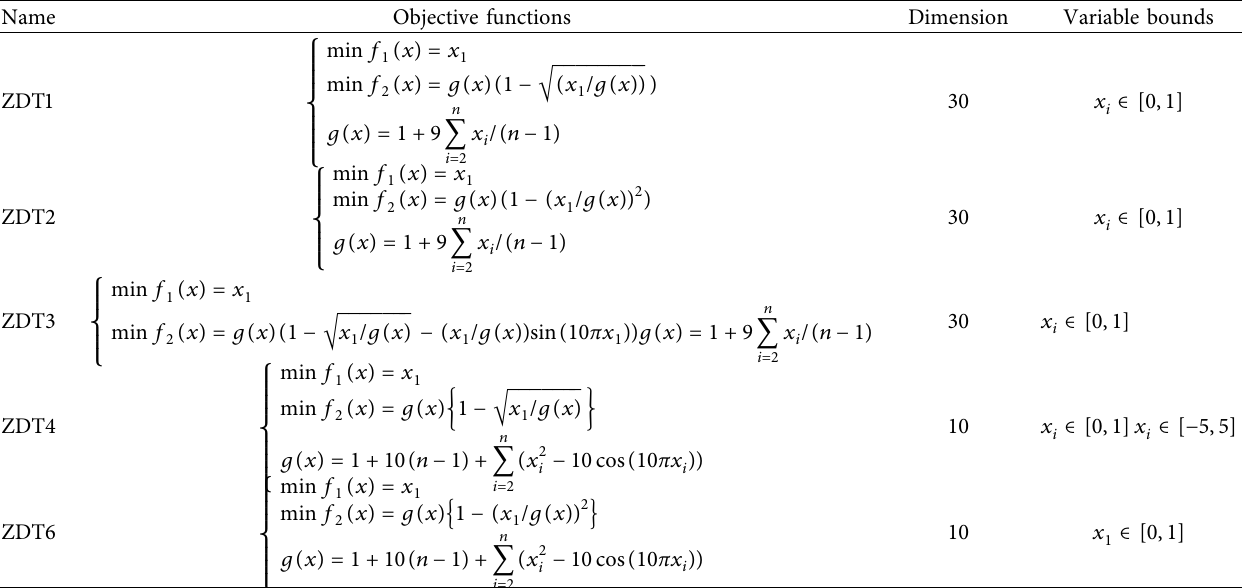
Table 2: Test functions: ZDT.